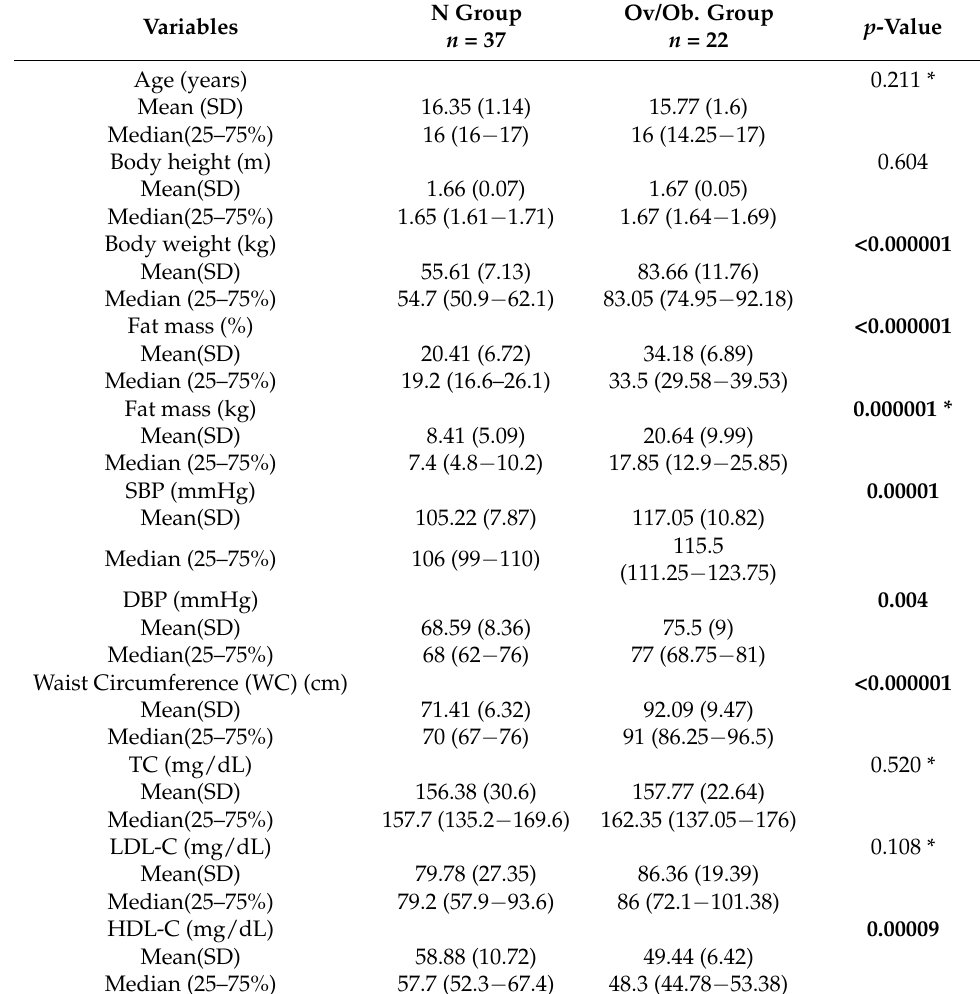
Table 1. Comparison of the baseline parameters including age, anthropometric, and metabolic parameter characteristics between